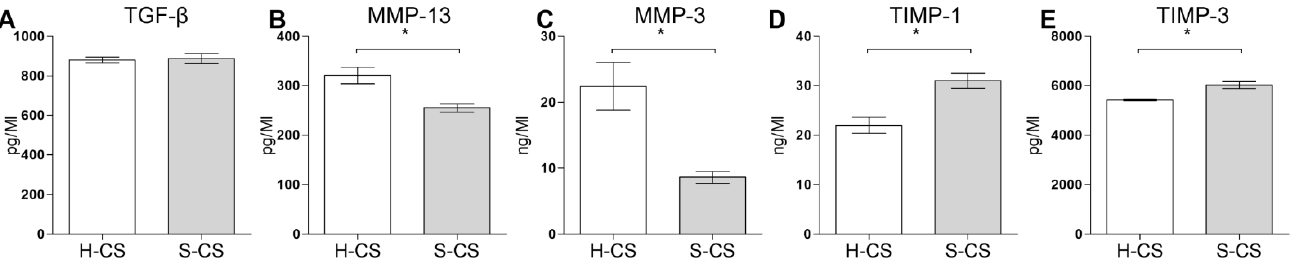
Figure 3. Comparison of the concentrations of humoral factors secreted by heterogeneous chondrocyte sheets (H-CS) and stratified chondrocyte sheets (S-CS). To determine the humoral factors’ expression levels, the cell culture medium was collected at 72 h after triple layer sheets were fabricated. The protein levels of ( A ) TGF- β 1, ( B ) MMP13, ( C ) MMP3, ( D ) TIMP-1, and ( E ) TIMP-3 were measured as Material and Methods described. Data are presented as bar with median concentration. (*, p < 0.05).